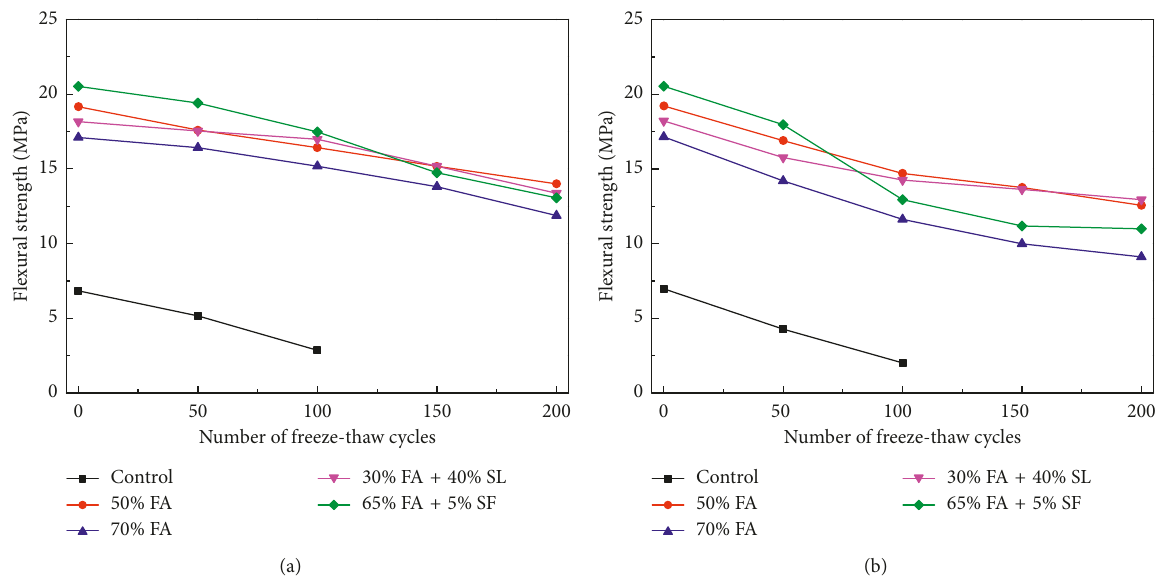
Figure 5: Flexural strength under freeze-thaw cycles: (a) in tap water and (b) in sodium chloride (NaCl)